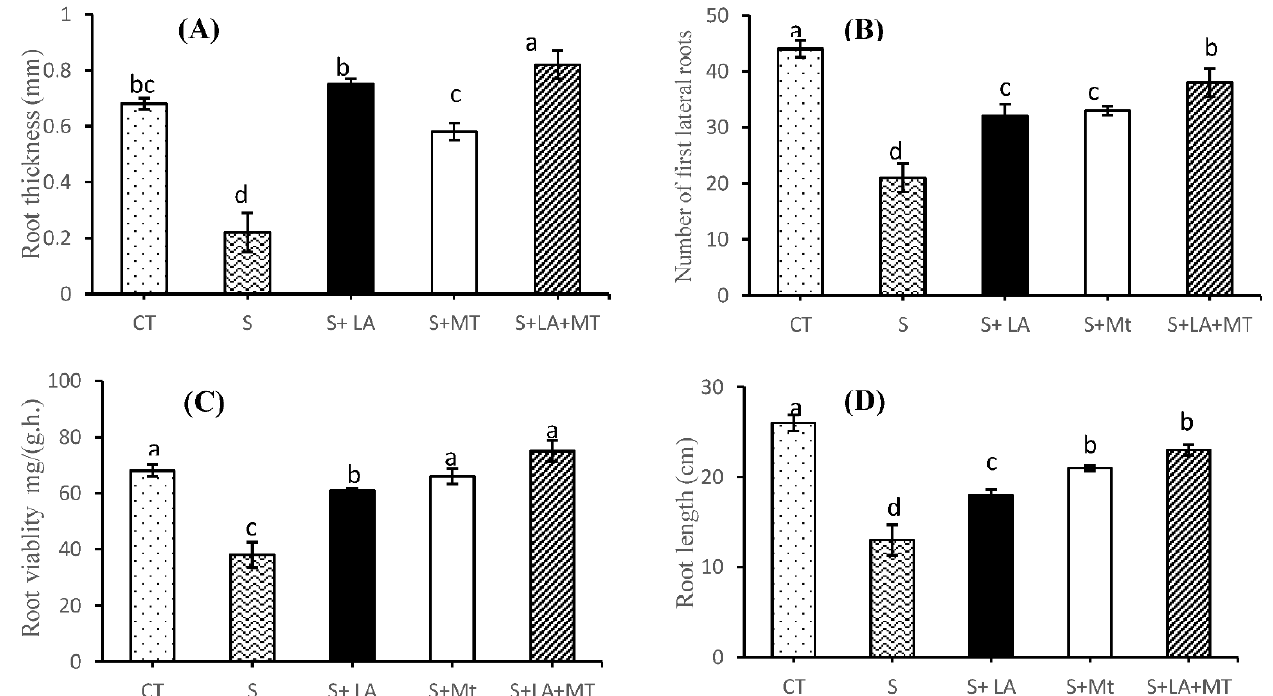
Figure 2. The effect of lipoic acid (LA), melatonin (MT), and their combination (LA + MT) under salt stress on root thickness ( A ), number of first lateral roots ( B ), root viability ( C ), root length ( D ) of Brassica napus L. seedling exposed to salinity (100 mM NaCl) for 30 days. Abbreviations are given in the Figure 1. Error bars on each column show the ± SE of three replication samples. Different letters on each bar indicate a significant difference according to the LSD test ( p ≤ 0.05).